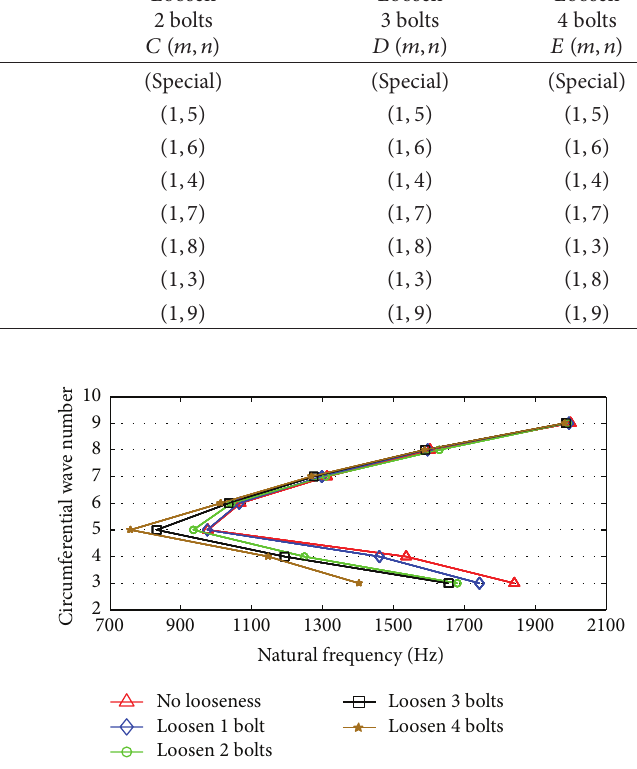
Figure 4: The relation between natural frequency and mode shape under BLB with different looseness